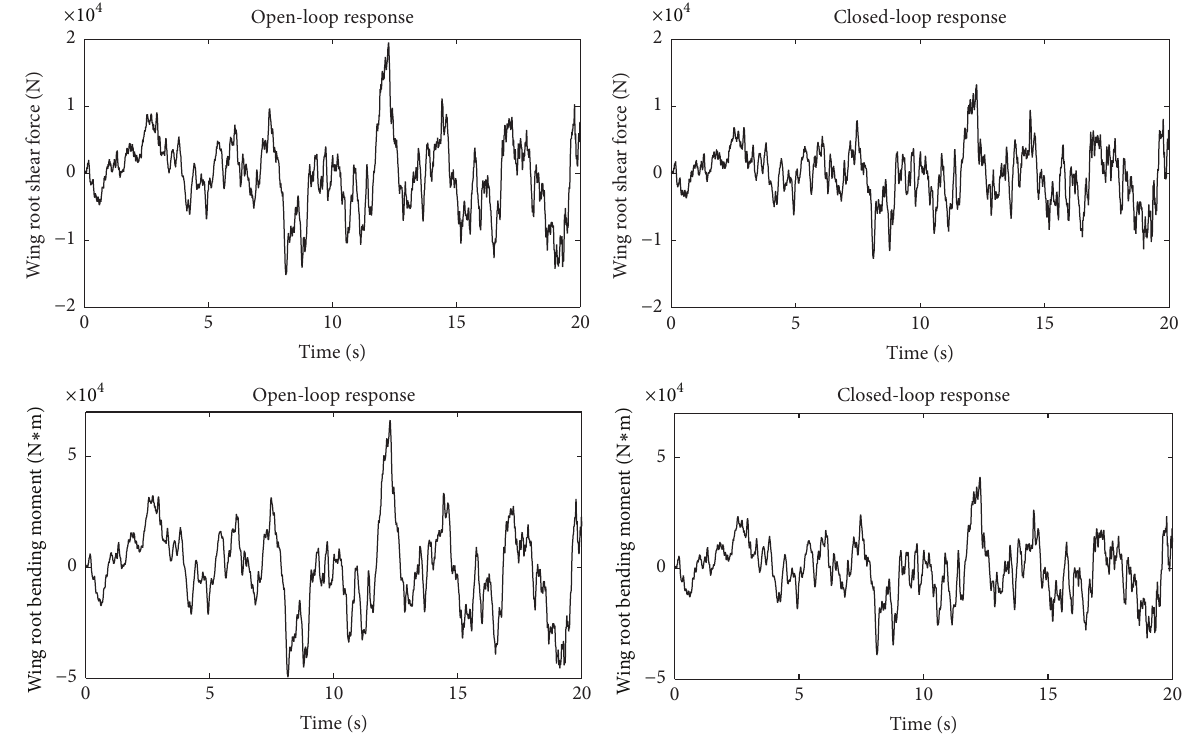
Figure 8: Time response of wing root shear force and bending moment to wind-gust input as Ma and 𝑞 vary.